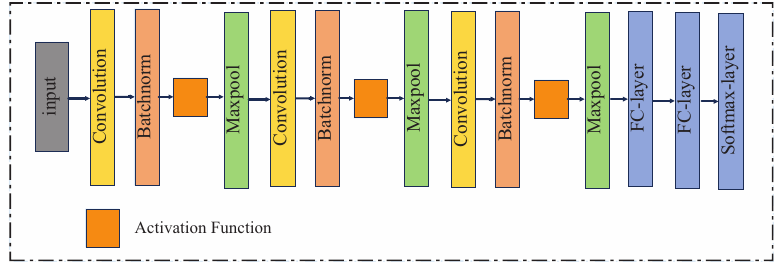
Figure 4. Detailed structure display of CNN. Table 1. The details of the designed CNN